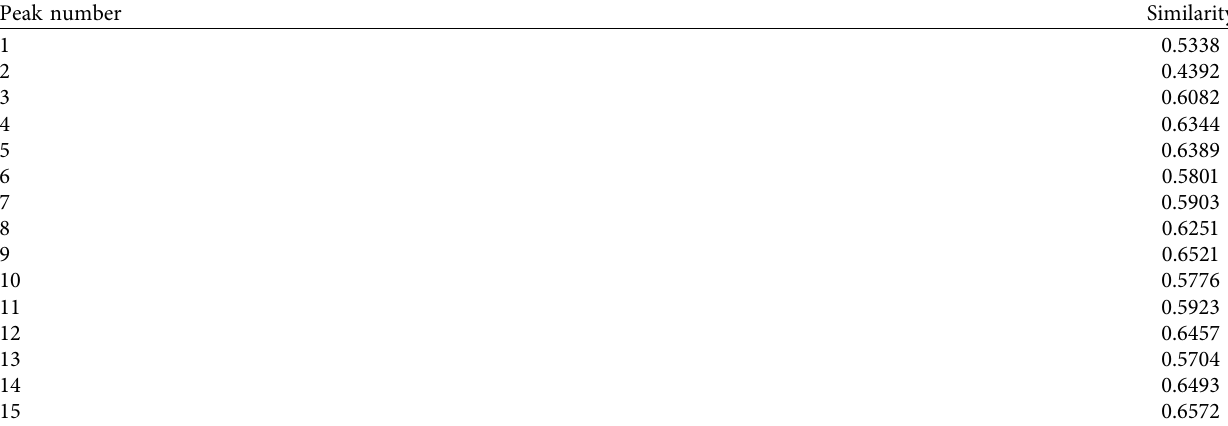
2 -induced cough test.